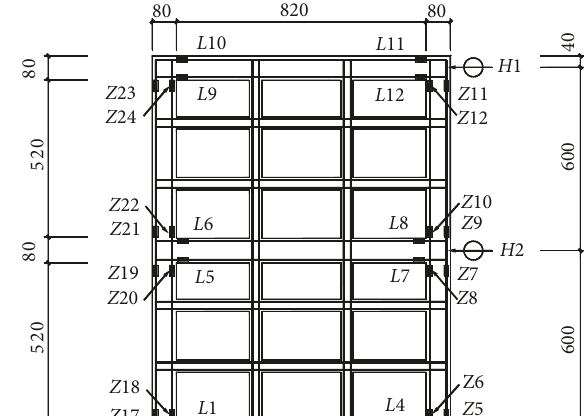
Figure 10: Loading cycles.